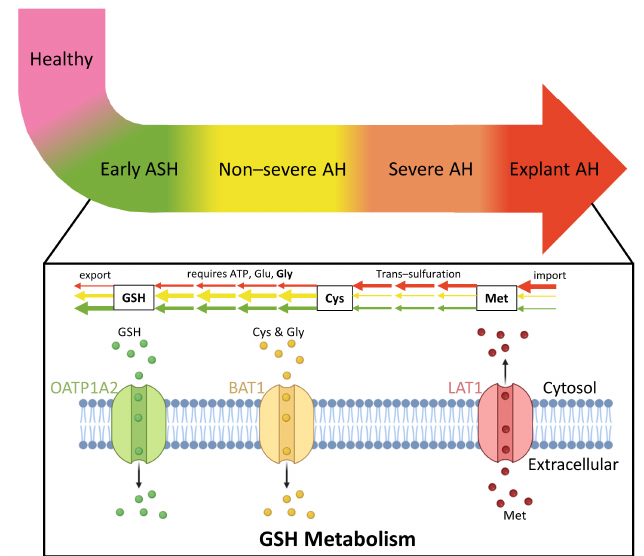
Figure 6. Glutathione (GSH) metabolism and transport activity is sequentially dysregulated with increasing AH severity. As AH severity increases, the earlier the steps in the GSH metabolism pathway are affected. While the early ASH disease state affects the last step in the pathway when GSH is exported, the explant AH state affects the first step in the pathway when methionine is imported to produce cysteine. Created with BioRender.com (accessed on 19 November 2022).